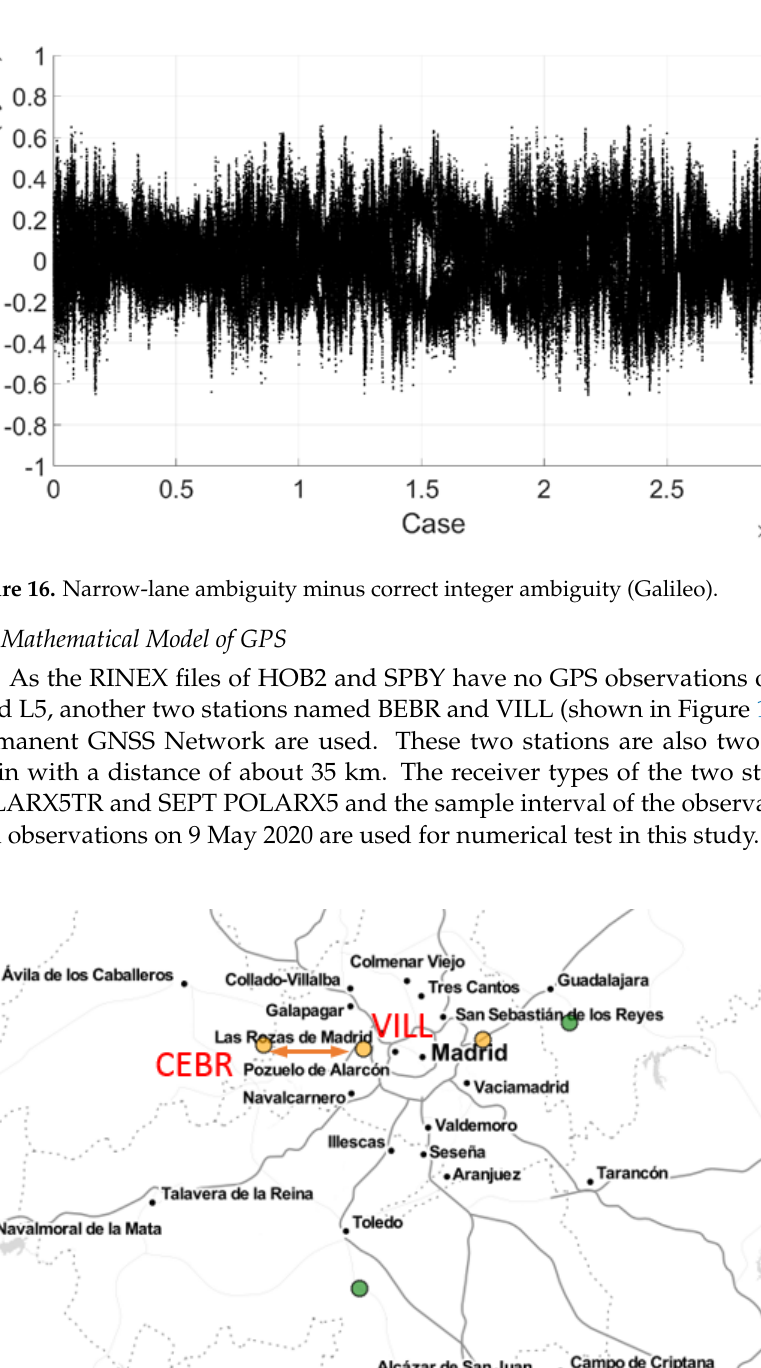
Figure 15. Statistics of mapping functions after differencing between satellites with closest mapping functions (Galileo).